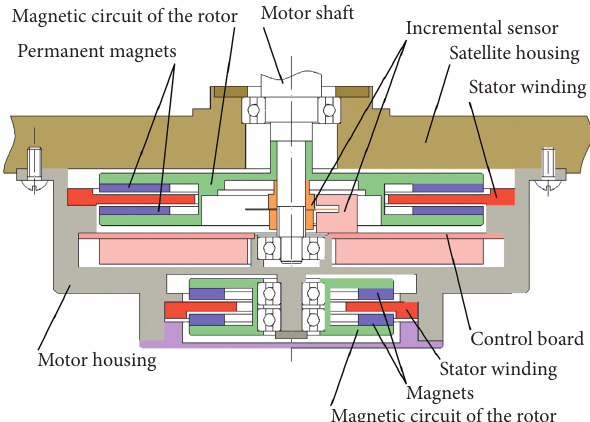
Figure 3: Electric motor of the scanning